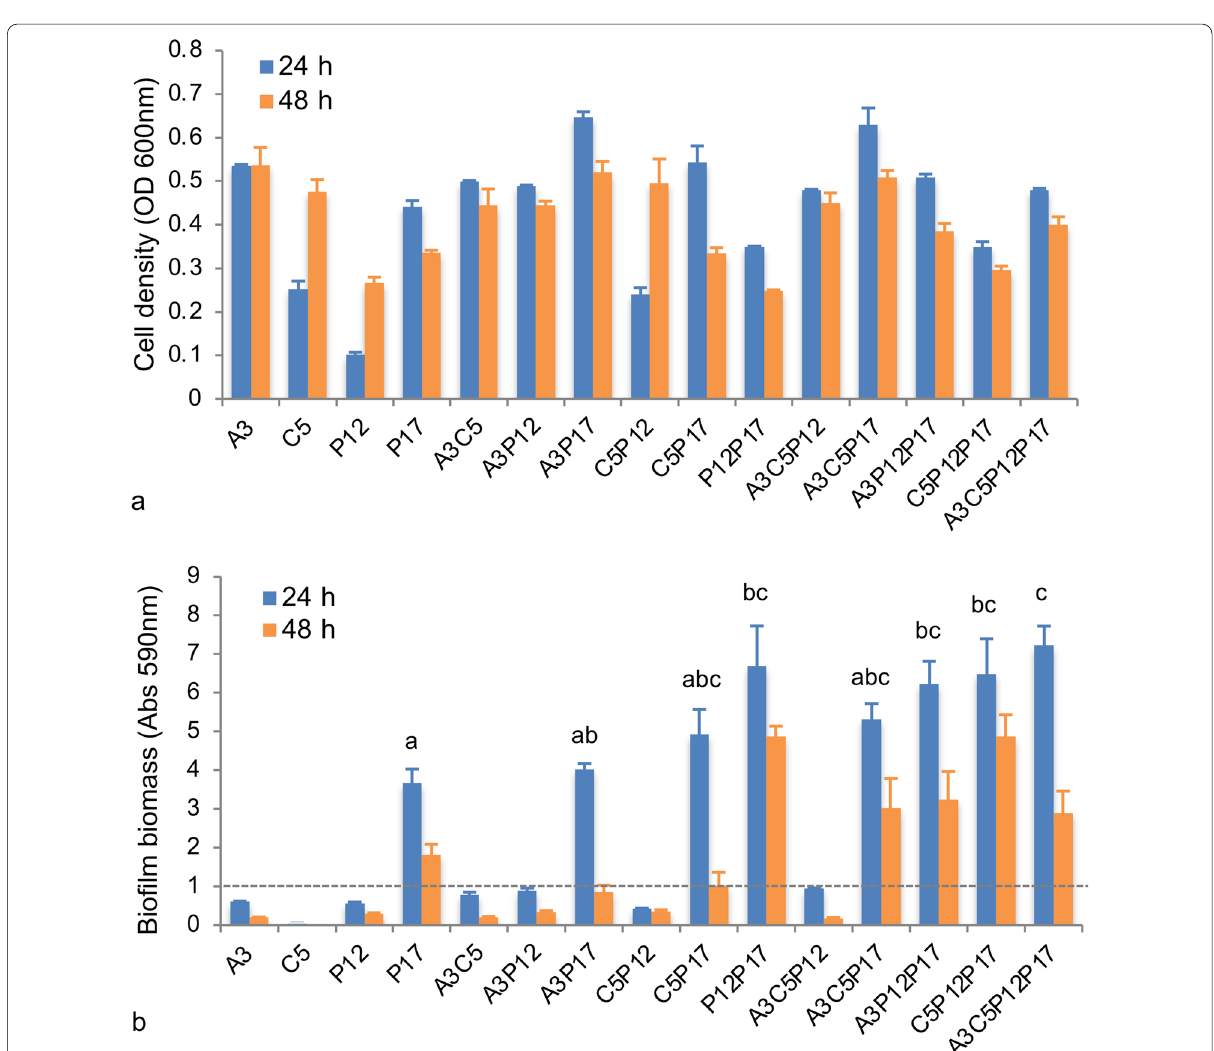
Fig. 2 Comparison of cell density and biofilm biomass from mono- and multi-species cultures after 24 and 48 h. a Measurement of cell density. b Measurement of biofilm biomass. A3: Acinetobacter sp. CTS3, C5: Corynebacterium sp. CTS5, P12: Providencia sp. CTS12, and P17: Pseudomonas sp. CTS17. Lowercases mean significant differences of biofilm-forming capacity (above 1.0 (CV value)) among the cultures after 24 h, showing by different letters based on one-way ANOVA using post-hoc Tukey’s HSD test ( p < 0.05). The detailed p values could be found in the Table